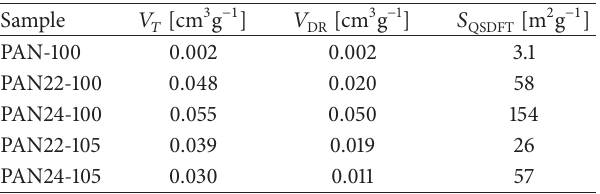
Table 2: Porosity parameters of PAN- PAN22- and PAN24-based